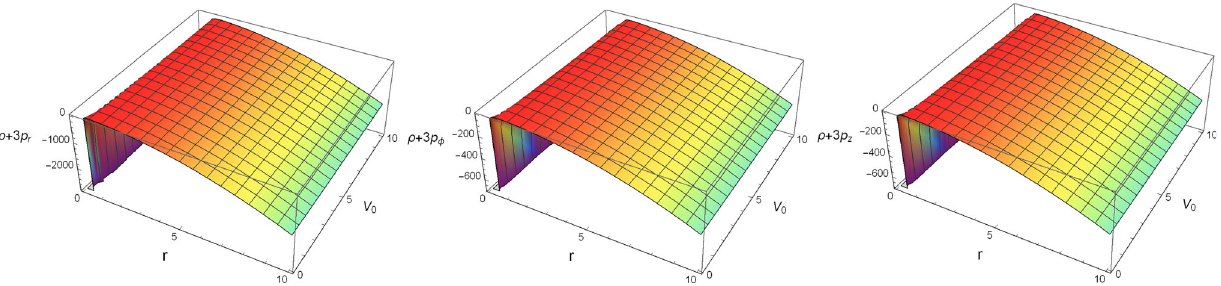
Fig. 35 Here, the graphical behavior of (ρ + 3 p r ) (MeV/fm 3 ) , (ρ + 3 p φ ) (MeV/fm 3 ) and (ρ + 3 p z ) (MeV/fm 3 ) w.r.t r (km) with m = n = 1 and C 0 = 0 . 5 shown in this panel. CASE (Cosmic String)